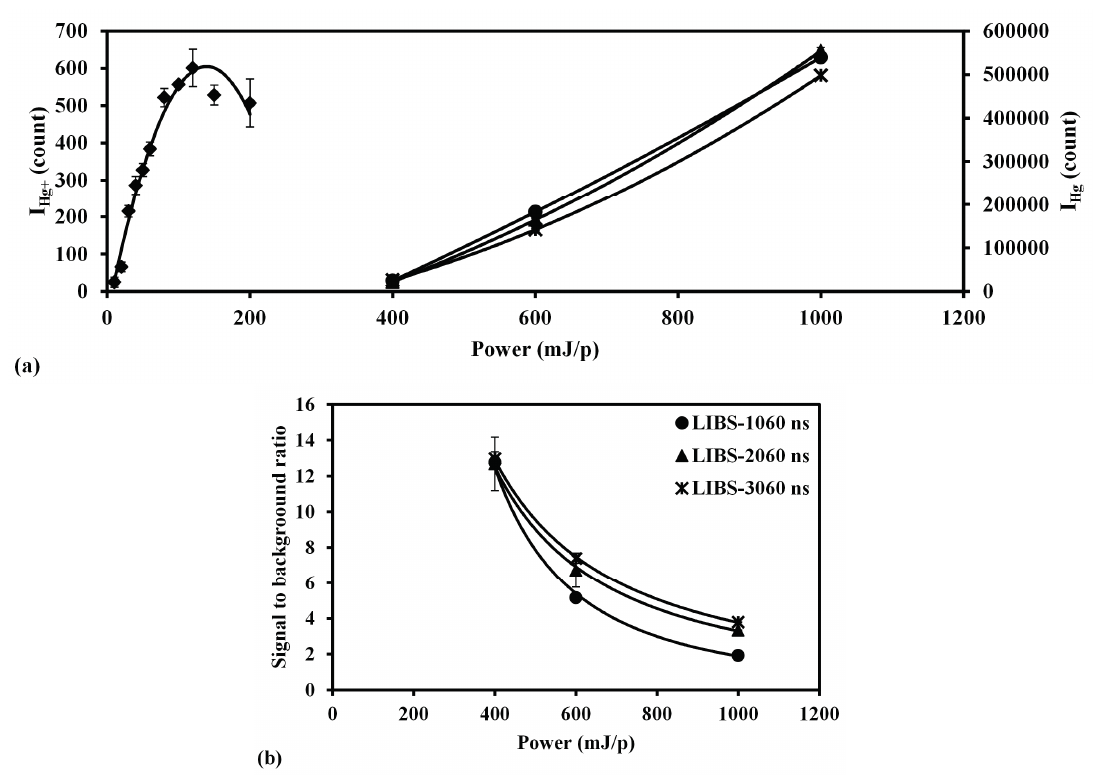
Figure 10. Dependence of Hg + and Hg emission signals on laser power using LB-TOFMS and LIBS. ( a ) Hg + and Hg emission signal intensities; ( b ) Hg signal to background ratio in LIBS. Conditions: LB-TOFMS, ns 532 nm laser irradiation, buffer gas N 2 , pressure 0.15 Pa, mercury concentration 3.2 ppm, lens angle α 10°. LIBS, ns 1064 nm laser irradiation, buffer gas N 2 , pressure 2600 Pa, beam diameter 9 mm, gate width 30 μ s, delay time 1060 ns, 2060 ns and 3060